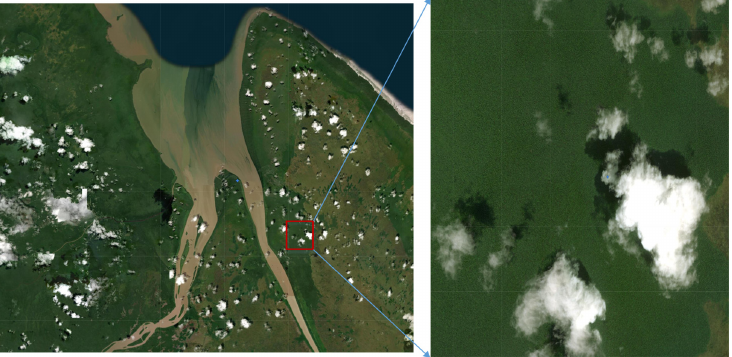
Figure 9. The selected Amazon-rainforest area was used for radiation-stabilization studies.